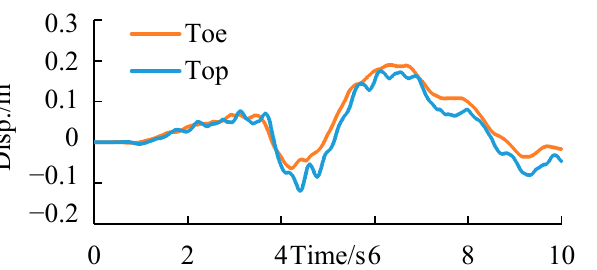
Figure 13. Displacement time–history curves of the monitoring points of the cut-and-fill subgrade.